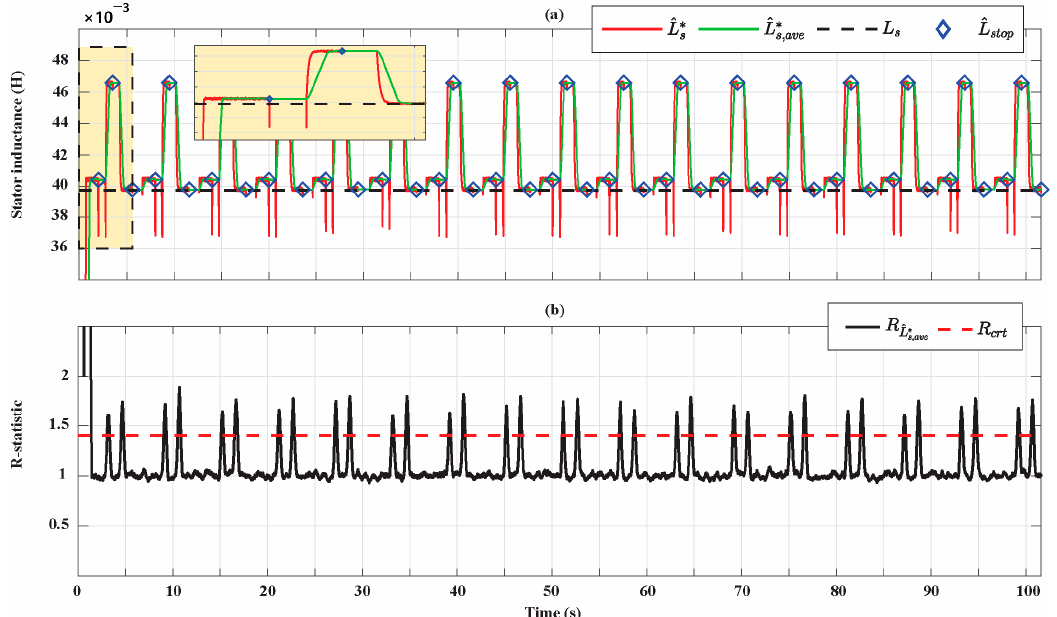
Figure 12. ( a ) Stator inductance estimation for the Bonfiglioli 65; ( b ) R-statistic analysis of the stator inductance estimation. Sensors 2021 , 21 , x FOR PEER REVIEW